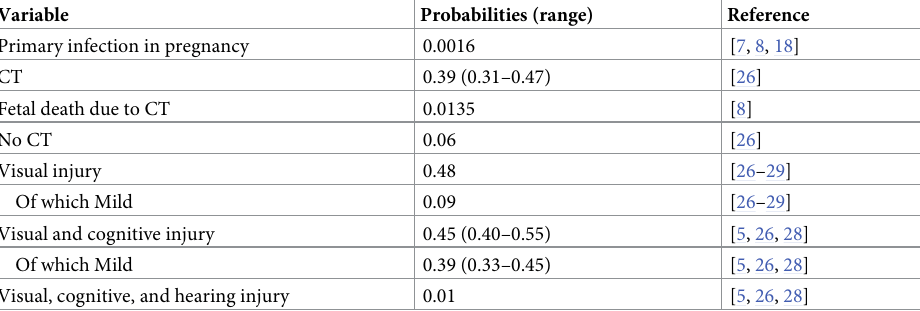
Table 1. Probabilities with no-screening option.